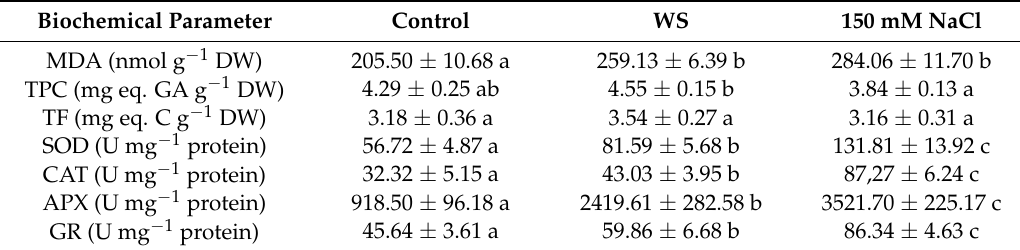
Table 1. Oxidative stress and antioxidant responses in Larix decidua . Malondialdehyde (MDA), total phenolic compounds (TPC), total flavonoids (TF) levels, and superoxide dismutase (SOD), catalase (CAT), ascorbate peroxidase (APX), and glutathione reductase (GR) specific activities, in methanol extracts (MDA, TPC, TF) or protein extracts (enzymes) of needles of Larix decidua seedlings after 30 days of water deficit (WS) and salt stress (150 mM NaCl) treatments 1